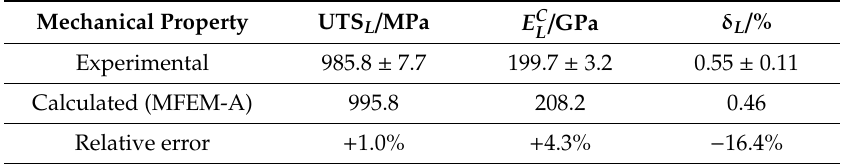
Table 9. Experimental and calculated mechanical properties at longitudinal tensile